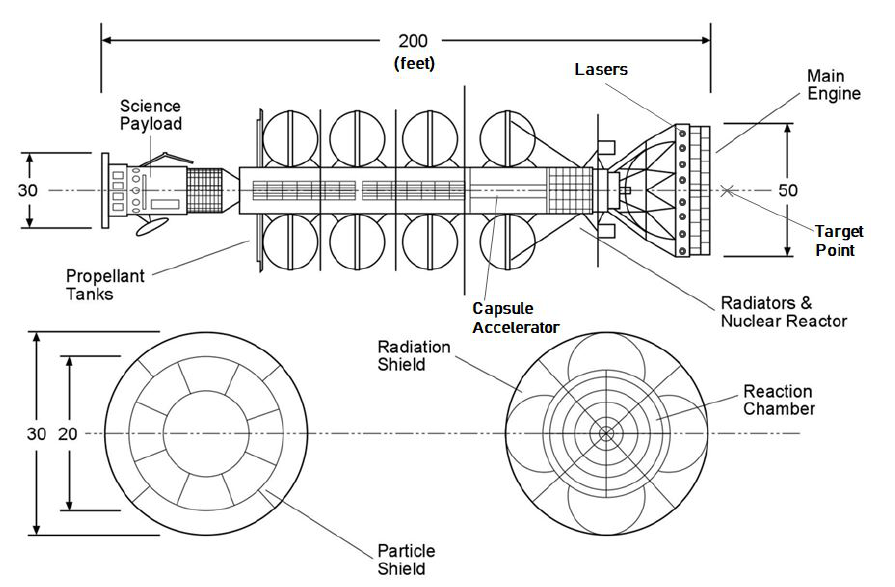
Figure 10. Concept vehicle design schematic for Icarus resolution interstellar flyby probe propelled by an ICF propulsion